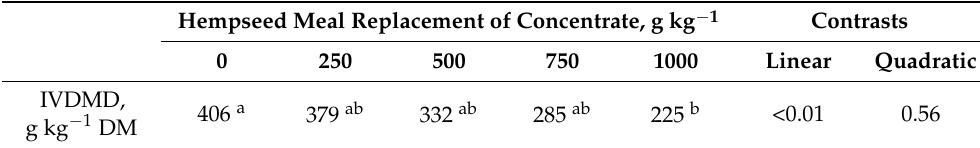
Table 3. In vitro dry matter digestibility (IVDMD) of a 60:40 forage-to-concentrate ratio mixture in which hempseed meal replaced the concentrate portion at various levels.